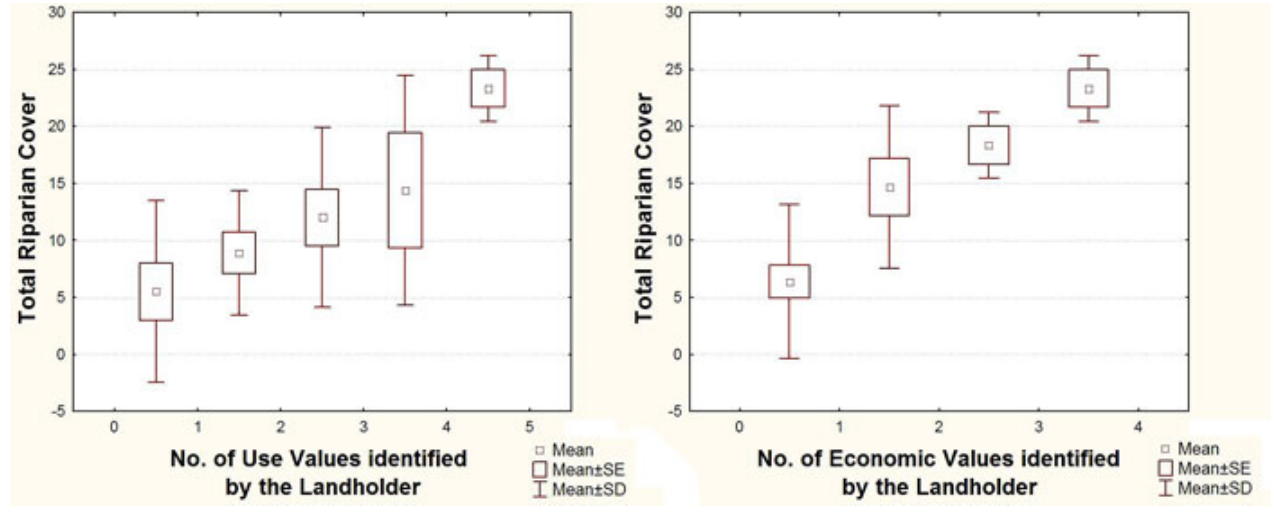
Fig. 4. Relationship between (i) total riparian cover (the proportion of established vegetation that exists in the margins: shrubs and trees, a sub-component of QBR ranging from 0–25%) and (ii) the number of use values identified by the landholder of the corresponding stream (left) and the number of economic use values identified by them (right, considered: water for cattle, shading for cattle, irrigation, rural tourism, and hunting renting contracts). N =